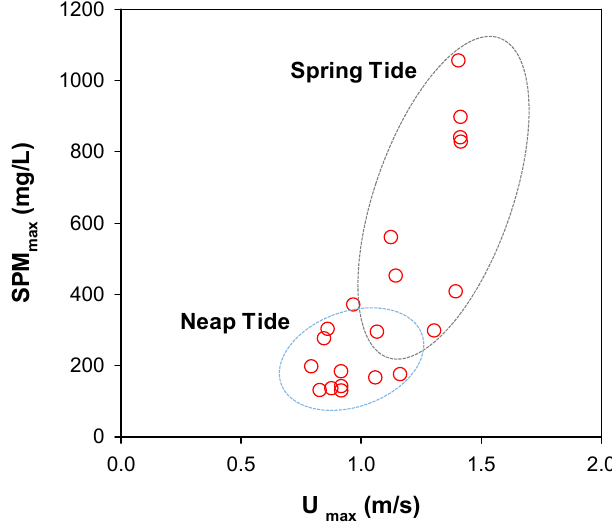
Figure 6. Plots of maximum suspended particulate matter concentration (SPMmax) versus maximum flow velocity (Umax). SPM concentration and flow velocity were measured in the middle of the water column. Each point represents a pair of SPMmax and Umax measured in a 13-h tidal cycle. All the data were measured in the turbidity maximum zone (TMZ) from 2004 to 2011.